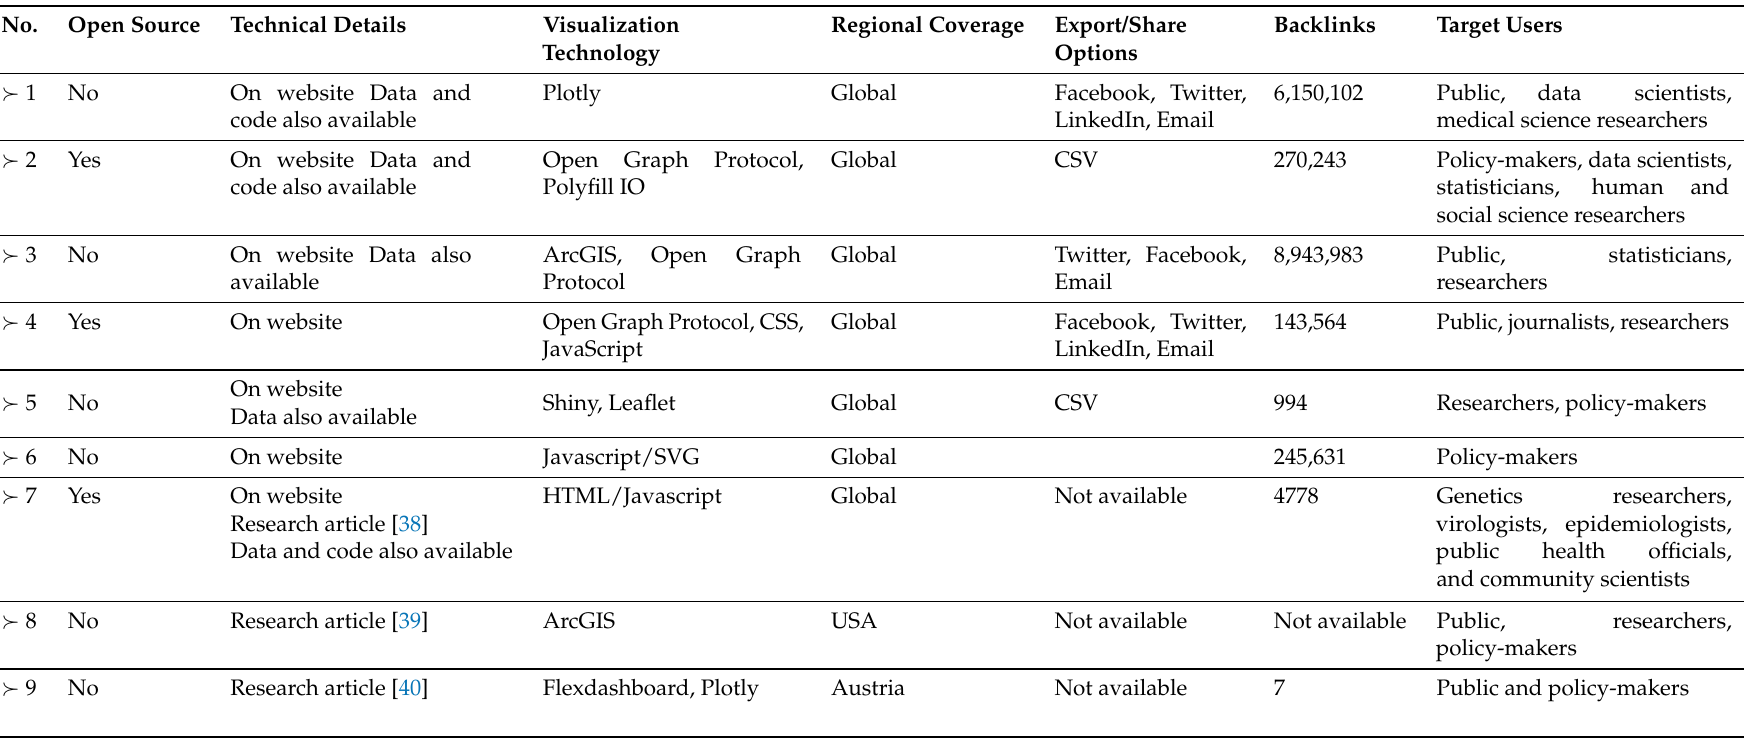
Table 5. Analysis of COVID-19 dashboards and epidemiological models using selected features (Part 2 of